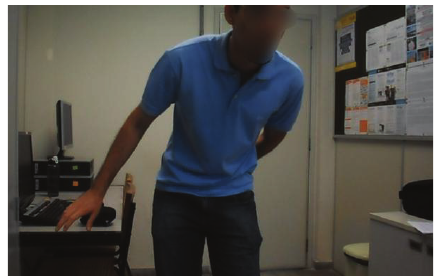
Figure 4: Subject getting closer to the screen to better see the pieces.